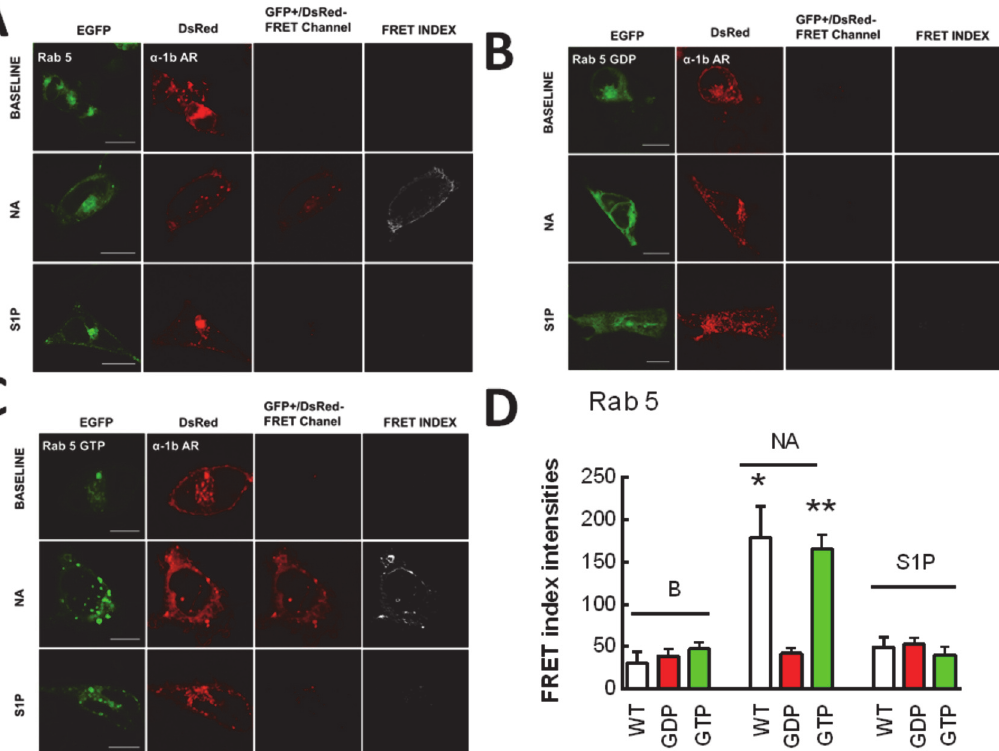
Fig 5. α 1B -Adrenergic receptor-Rab 5 interaction. Images of cells coexpressing α 1B -adrenergic receptors tagged with the DsRed fluorescent protein ( α 1B - AR) and Rab 5 tagged with the enhanced green fluorescent protein (EGFP). Other indications as in Fig. 1. Panel A, wild-type Rab 5 (WT); panel B, dominant- negative Rab 5 (Rab 5-GDP); and panel C, constitutively active Rab 5 (Rab 5-GTP). In panel D, the quantitative analysis of the FRET index is presented. Plotted are the means and vertical lines representing the S.E.M of 5 – 7 experiments using different cell preparations. * p < 0.001 vs. wild-type baseline (B) and stimulated with sphingosine 1-phosphate (S1P). ** p < 0.001 vs. Rab 5-GTP baseline (B) and stimulated with sphingosine 1-phosphate (S1P). Scale bars: 15 μ